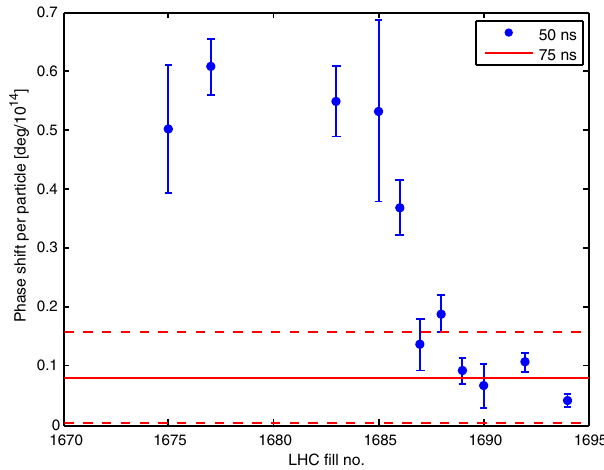
FIG. 5. Ratio of the phase shift to total beam intensity for different LHC fill with 50 ns beams (blue circles) and mean value (solid red line) together with standard deviation (dashed red lines) of the same ratio for the 75 ns beams. After scrubbing run in April 2011 the value of the ratio for the 50 ns beams converged to the 75 ns beams